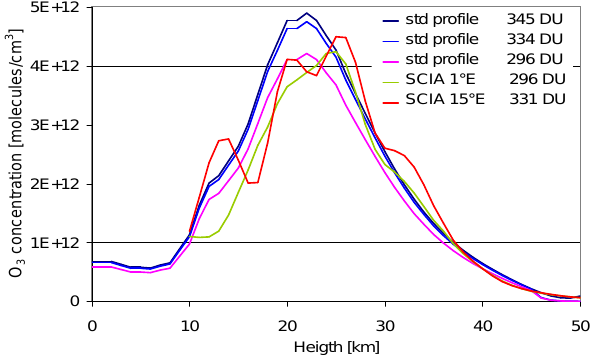
Figure 4. Time series of the O 3 vertical column density (VCD) from above Cabauw during the period of our measurements (indicated by the black